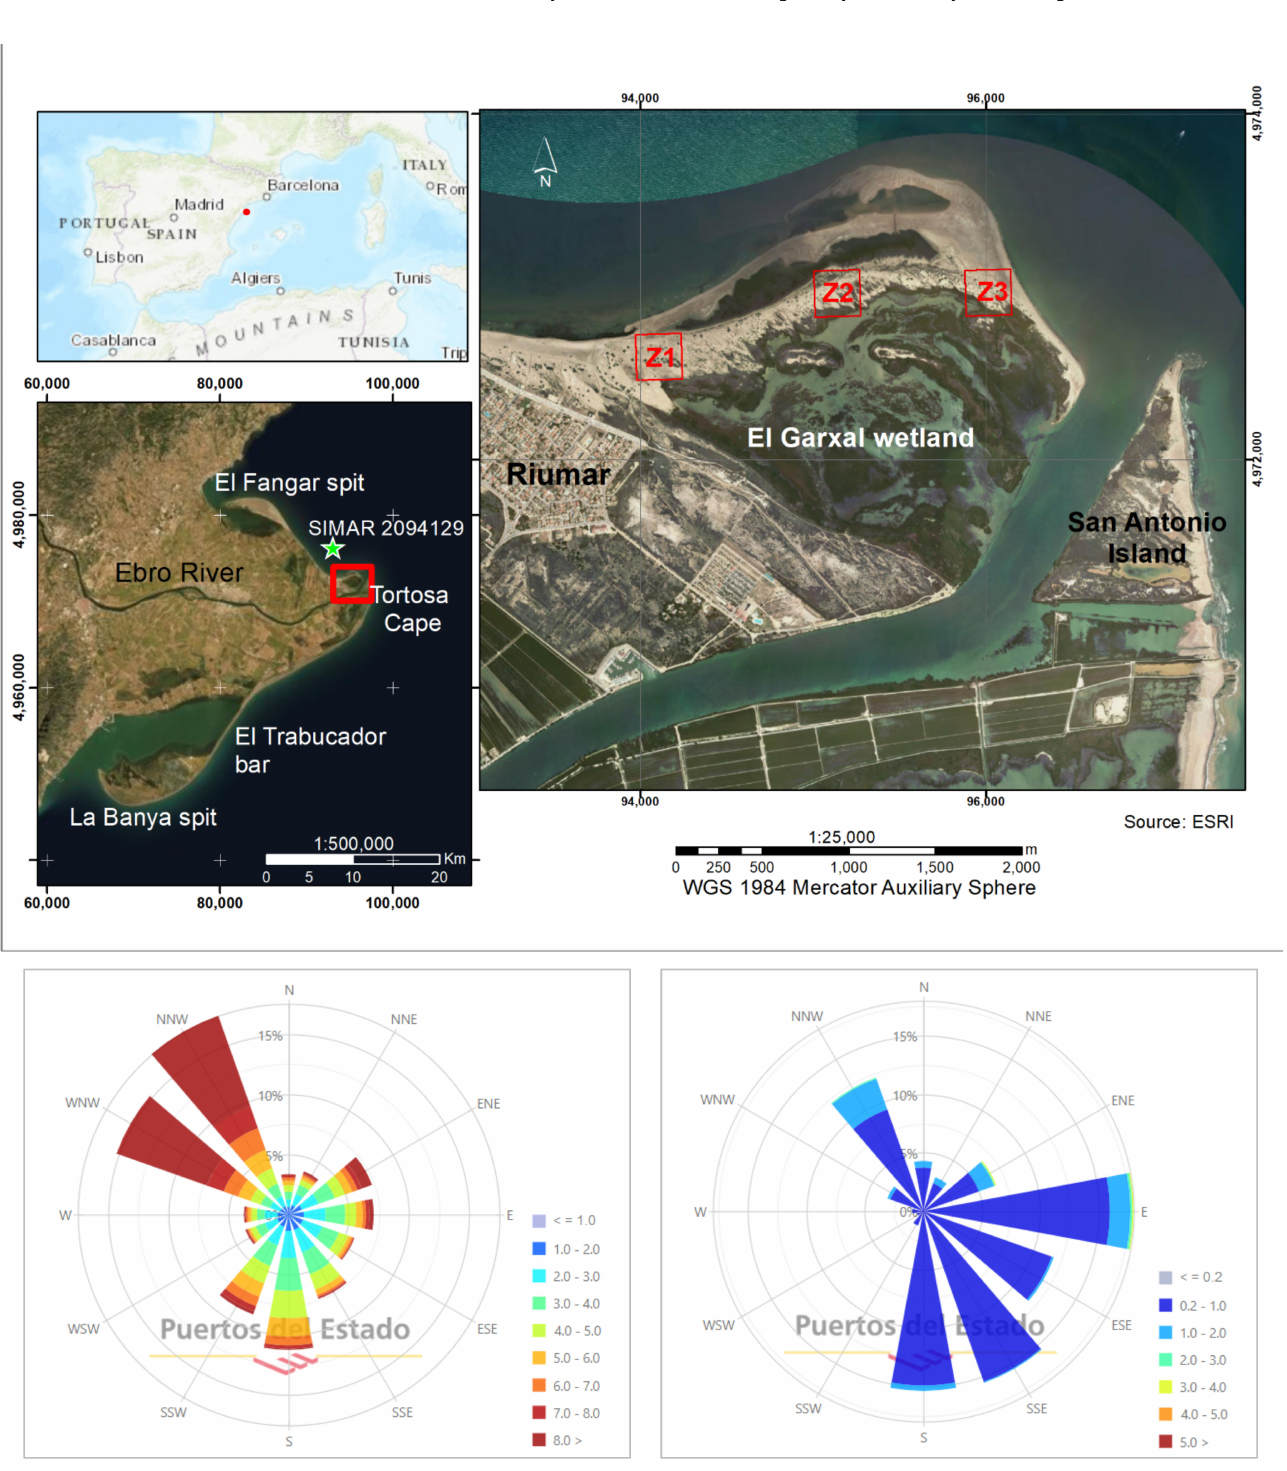
Figure 1. Map showing the location of the El Garxal coastal wetland and the Riumar dune field. The red squares show the three sites selected (Z1, Z2, and Z3). The bottom left chart shows the Wind rose (average wind speed (m/s)), and the right chart, the Wave rose (significant wave height (m)) of SIMAR Point 2094129 (the green star in the left-hand graph). Period: 2010–2018. Efficiency: 99.83%. Reproduced from Puertos del Estado (http://www.puertos.es/ (accessed on 2 March